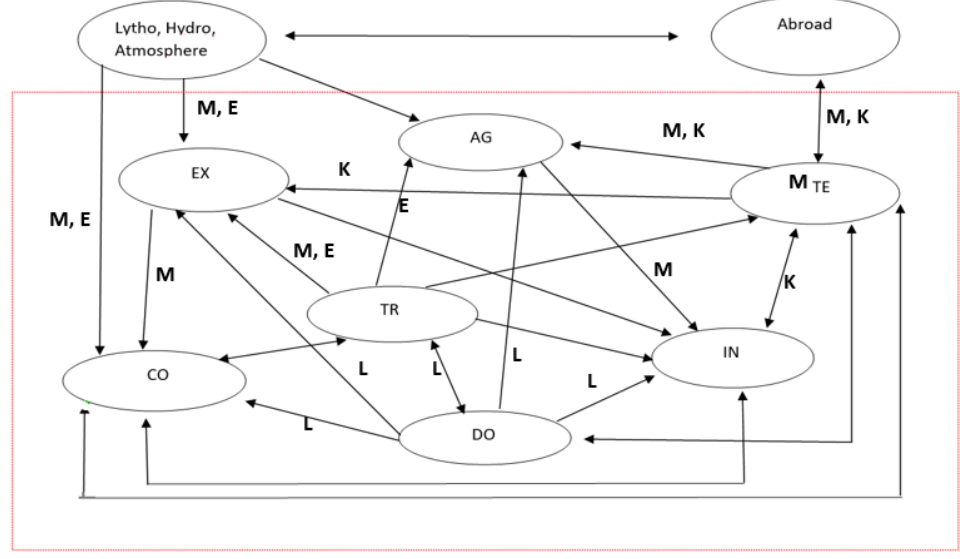
Figure 1. Qualitative scheme of different material (M), energy (E), monetary (K), and labor (L) flows among the different sectors (schematic: not all flow types are shown).